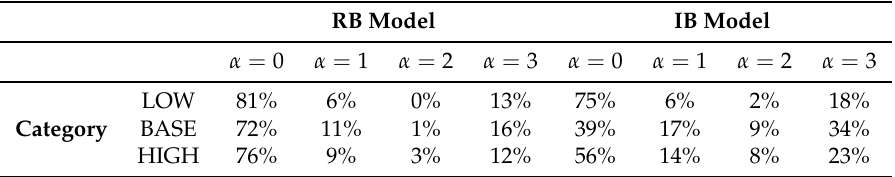
Table 4. Occurrence of different activities within the equilibrium schedules for different player categories and both battery models. Results are obtained by averaging over all